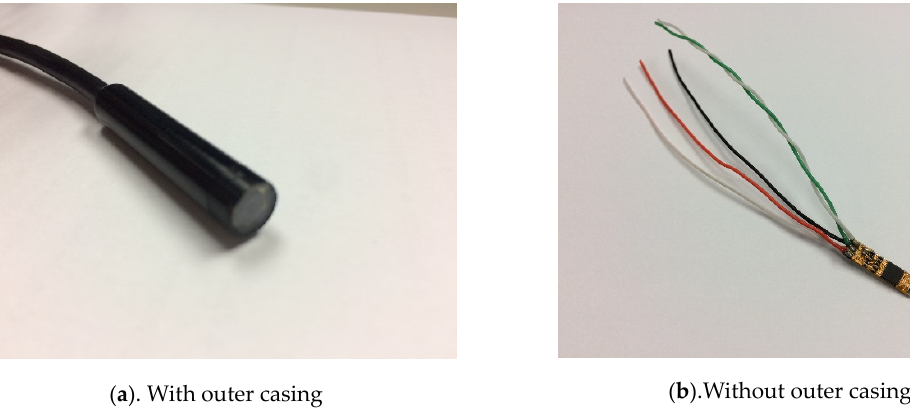
Figure 2. The proposed camera modules.